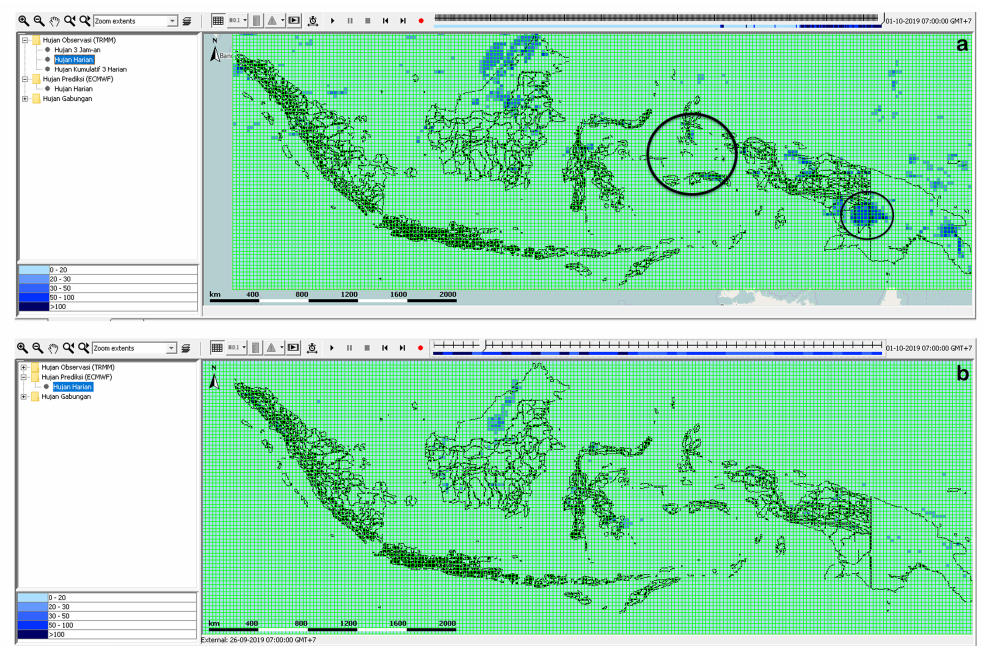
Figure 4. Examples of spatial precipitation data on 1 October 2019: ( a ) precipitation observed by the Tropical Rainfall Measuring Mission (TRMM) satellite; and ( b ) precipitation forecasted by the Meteorological, Climatological, and Geophysical Agency (BMKG) with a lead-time of 1 day. Black circles indicate Maluku Islands (left) and Papua Island (right).